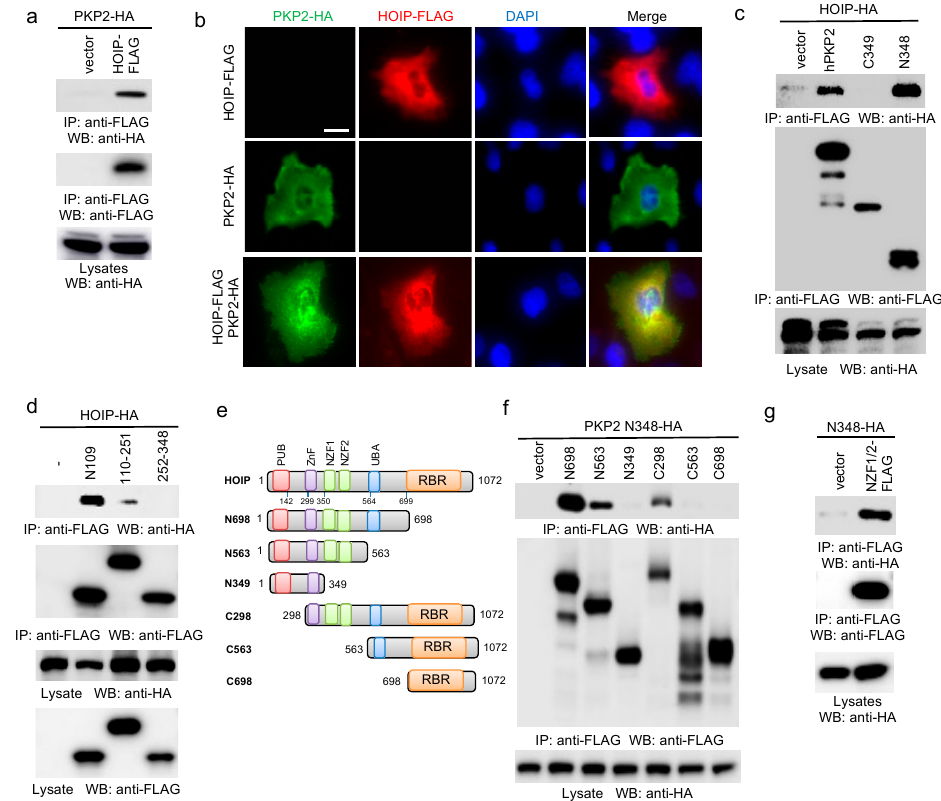
Figure 2. PKP2 interacts and co-localizes with HOIP. ( a ) FLAG-tagged HOIP (HOIP-FLAG) was co- transfected with PKP2-HA into HEK293 cells. After 48 h, cell lysates were immunoprecipitated with an anti-FLAG antibody and blotted as indicated. ( b ) HOIP-FLAG and PKP2-HA were transfected into A431 cells. After 48 h, cells were fixed and stained as indicated. FLAG: red; HA: green; DAPI, blue. Bar = 10 µ m. ( c ) HA-tagged HOIP (HOIP-HA) was transfected with PKP2-FLAG or the indicated mutants into HEK293 cells. After 48 h, cell lysates were collected and then immunoprecipitated and blotted as indicated. ( d ) HOIP-HA was transfected with the indicated FLAG-tagged PKP2 mutants into HEK293 cells. After 48 h, cell lysates were collected and then immunoprecipitated and blotted as indicated. ( e ) Schematics of HOIP mutants. PUB: PNGase/UBA- or UBX-containing domain; ZnF: zinc finger; NZF: Npl4-type zinc finger; UBA: ubiquitin-associated domain; RBR: RING-IBR-RING domain. ( f ) HA-tagged PKP2 N348 was transfected with the indicated FLAG-tagged HOIP mutants into HEK293 cells. After 48 h, cell lysates were collected and then immunoprecipitated and blotted as indicated. ( g ) HA-tagged PKP2 N348 was transfected with FLAG-tagged two NZF domains (NZF1/2) into HEK293 cells. After 48 h, cell lysates were collected and then immunoprecipitated and blotted as